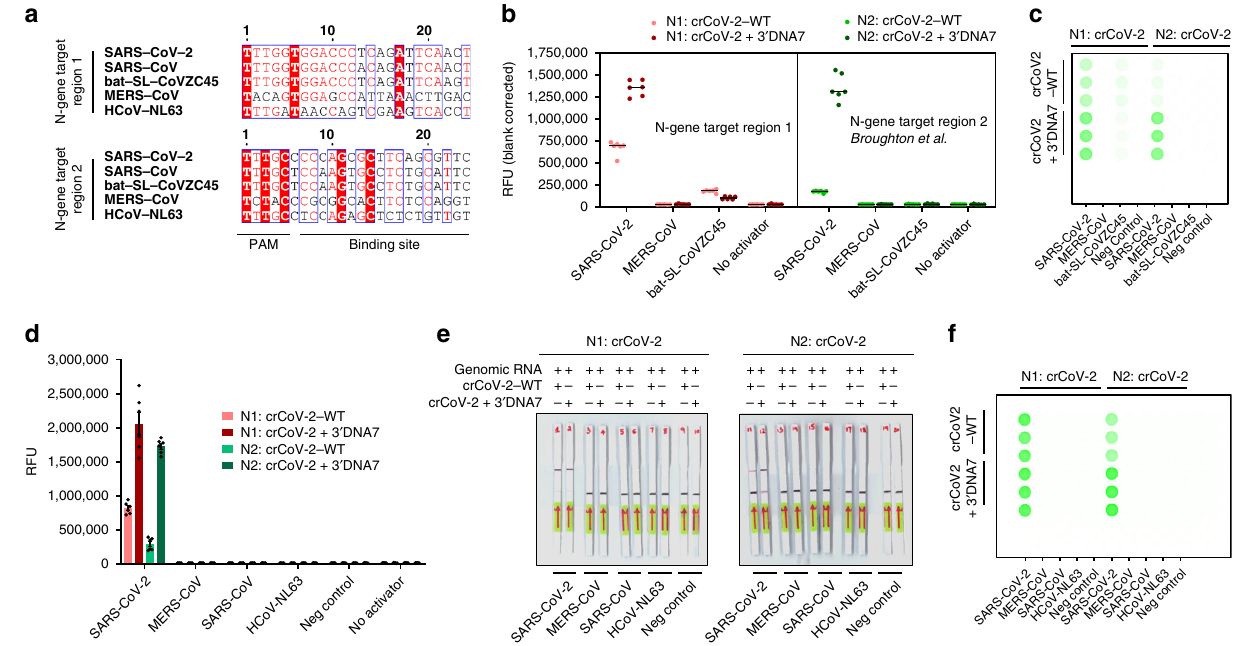
Fig. 7 Enhanced sensitivity and speci fi city with ENHANCE for detecting SARS-CoV-2 genomic RNA. a Sequence alignment of similar pathogens from the same family with SARS-CoV-2 that were tested in this study. Two crRNAs including their engineered version were designed to target two regions of the N gene N1 and N2 (N1: crCoV and N2: crCoV) where N2 was reported in Broughton et al. Sequences were aligned using ClustalOmega 31,32 , exported in aln fi le and graphically enhanced in ESPript 3.0 33 . b crRNA speci fi city towards SARS-CoV-2 and other highly similar pathogens from the same family. The targets were dsDNA ampli fi ed from plasmid controls 2019-nCoV_N_Positive Control, MERS-CoV Control, and SARS-CoV Control (IDT). c Detection reaction in b scanned by Typhoon (Amersham, GE healthcare). d crRNA speci fi city towards genomic RNA of SARS-CoV-2 and other genomic RNAs of highly similar pathogens from the same family. The targets were genomic RNA obtained from BEI Resources. e Lateral fl ow assay of d . f Detection reaction in d scanned by Typhoon (Amersham, GE healthcare). For b , and d , error bars represent mean ± SEM, where n = 6 replicates (three technical replicates examined over two independent experiments). Source data are available in the Source Data fi